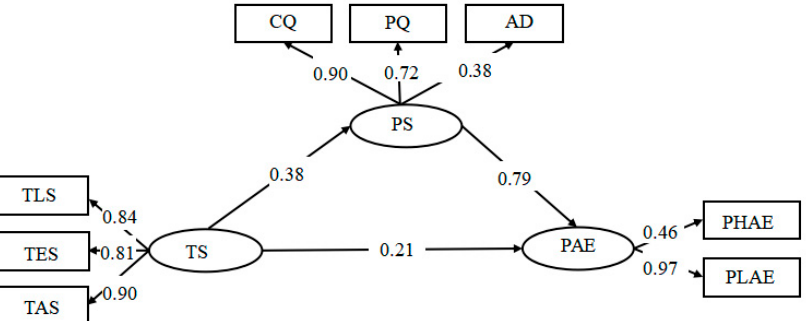
Figure 1. SEM with TS, PS, and PAE. TLS = teacher learning support, TES = teacher emotional support, TCS = teacher ability; CQ = cognitive quality; PQ = personality quality; AD = adaptability; PHAE = positive high-arousal academic emotion; PLAE = positive low-arousal academic emotion.